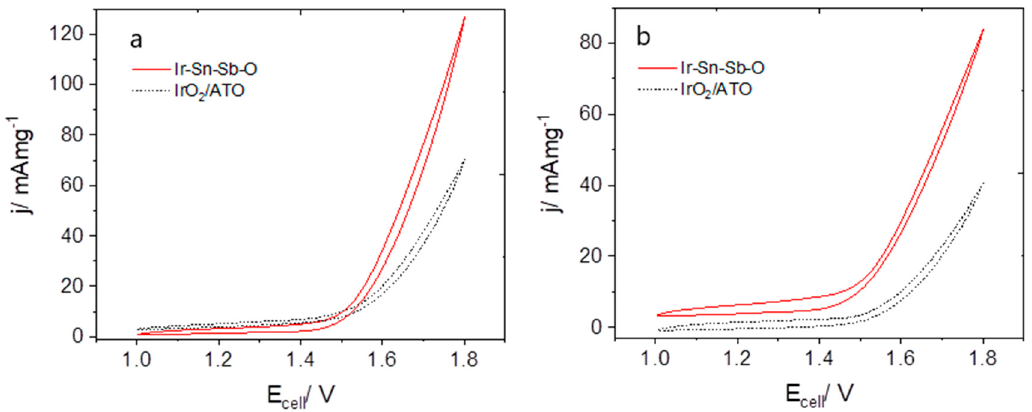
Figure 7. Cyclic voltammetry of IrO 2 / ATO (- - -) and Ir-Sn-Sb-O ( ___ ) MEAs. ( a ) Before and ( b ) after polarization. 70 °C and 7 mL min − 1 , ν = 100 mV s − 1 .